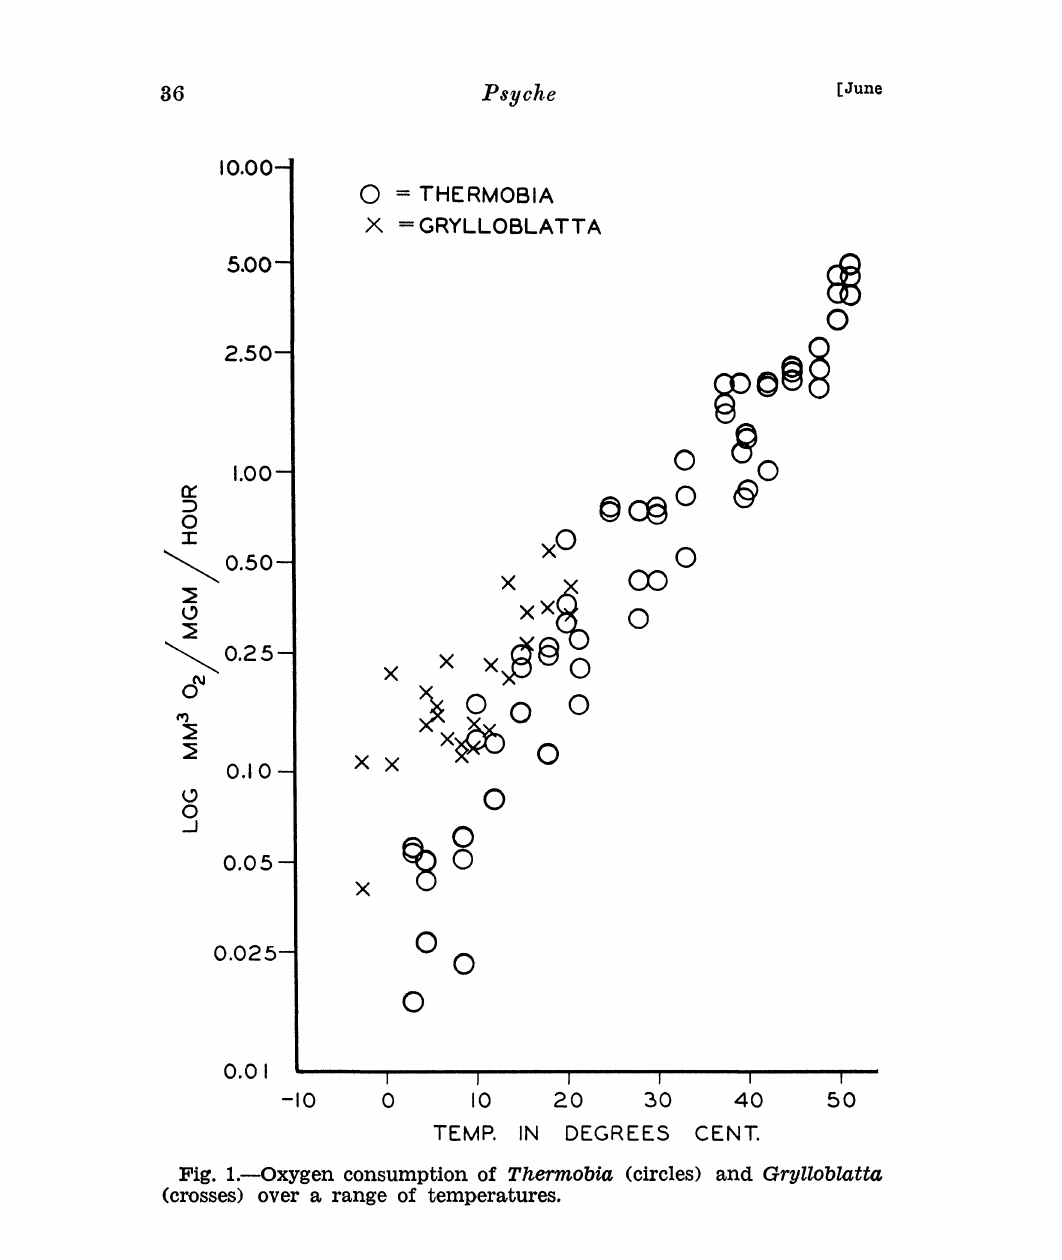
Fig. 1.--Oxygen consumption of Thermobia (circles) and Grylloblatta (crosses) over a range of